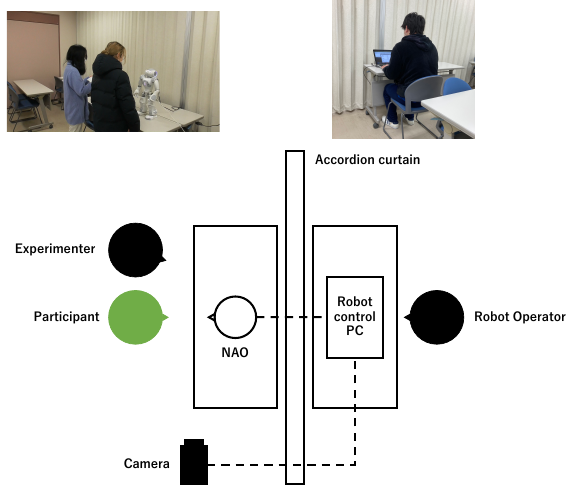
Figure 1. Experimental